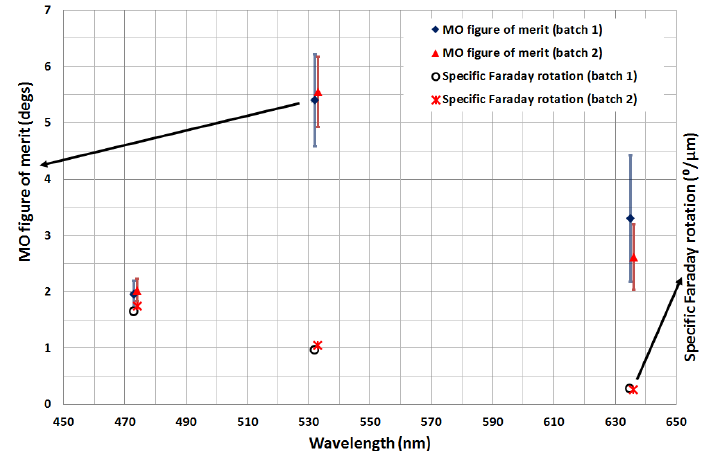
Figure 12. Measured specific Faraday rotation data and magneto-optic (MO) figures of merit at 473 nm, 532 and 635 nm.